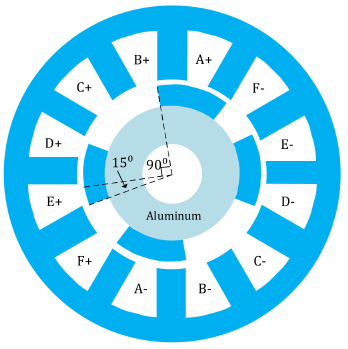
Figure 7. Structure of the multi-stack segSRM edited from [60].